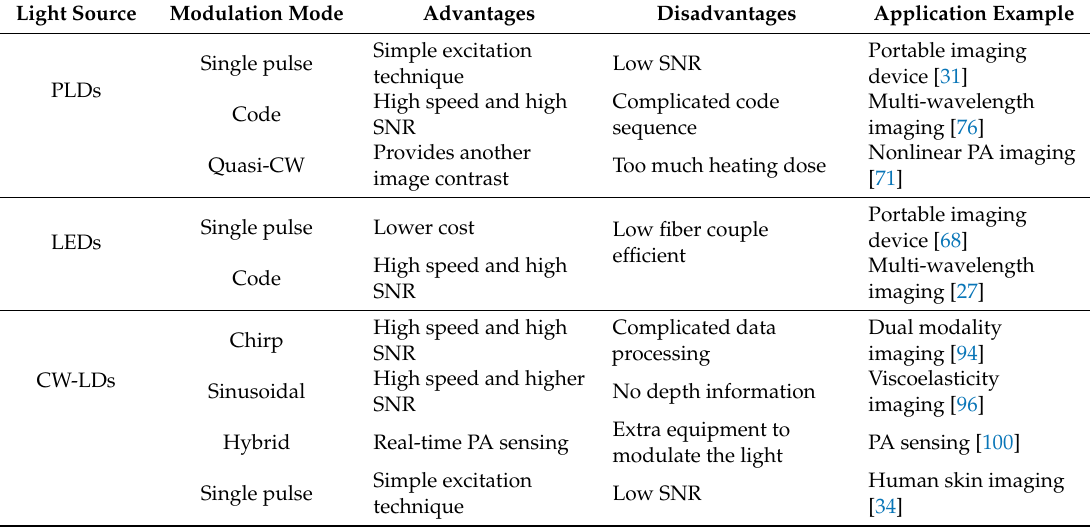
Table 1. The summary of different modulation modes based on different light sources. PLDs, pulsed laser diodes; CW-LDs, continuous laser